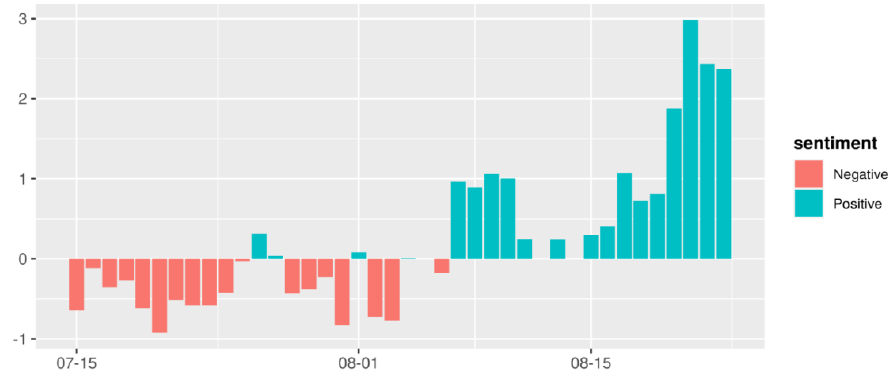
Figure 5. Daily sentiment score of the